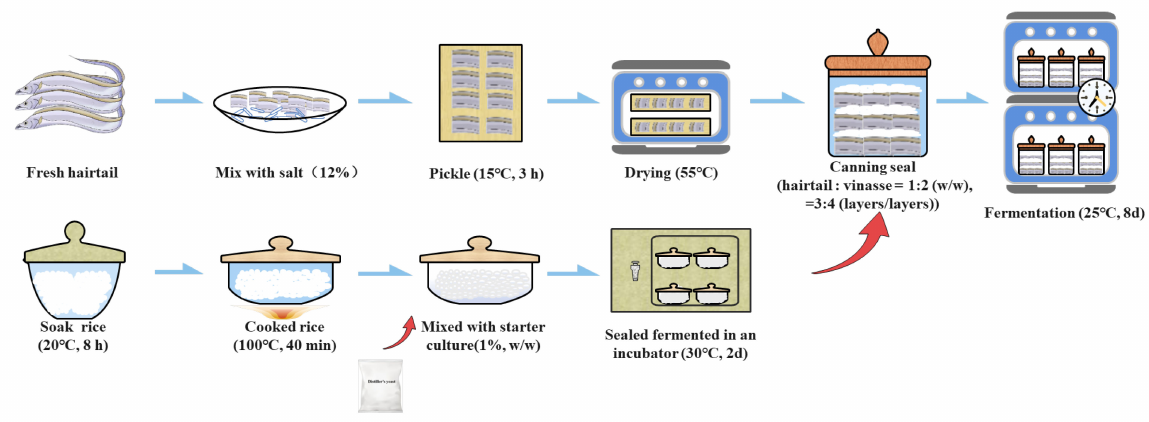
Figure 1. The schematic procedure of vinasse hairtail